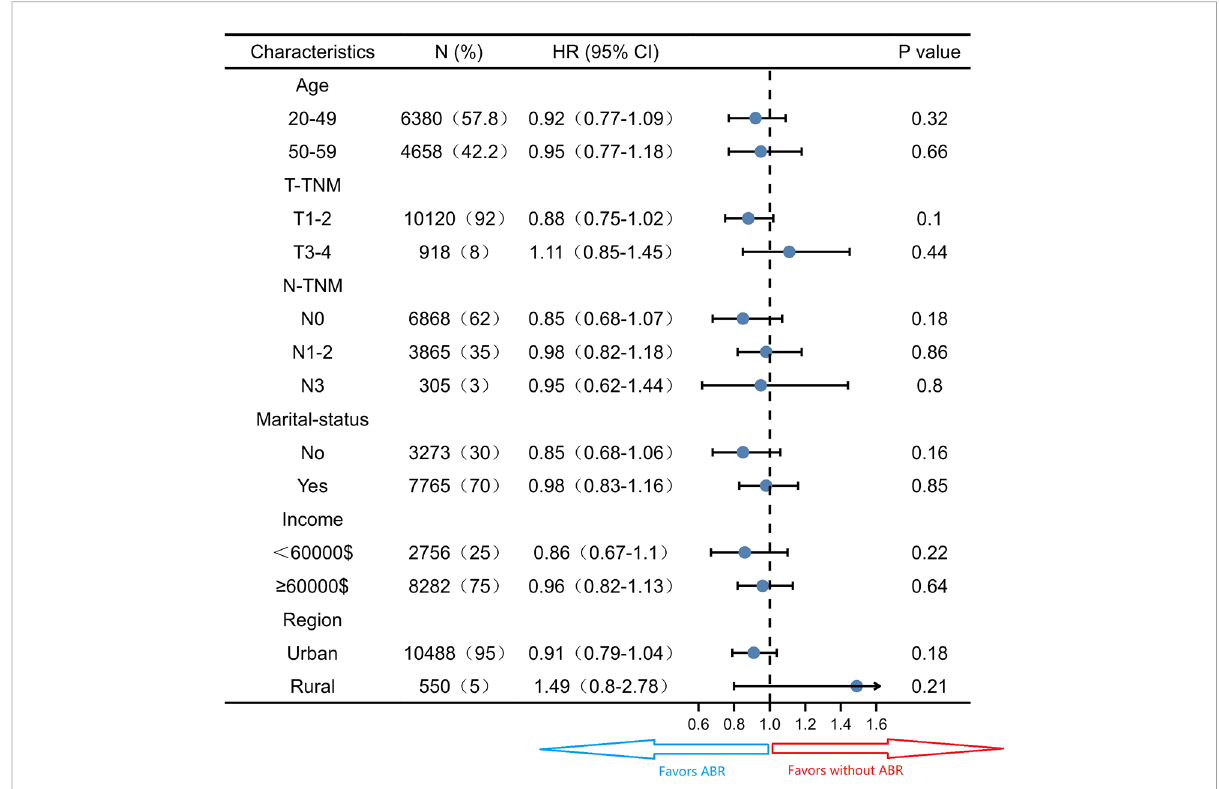
FIGURE 4 Subgroup analysis of cancer speci fi c survival in propensity score matched cohort (N =